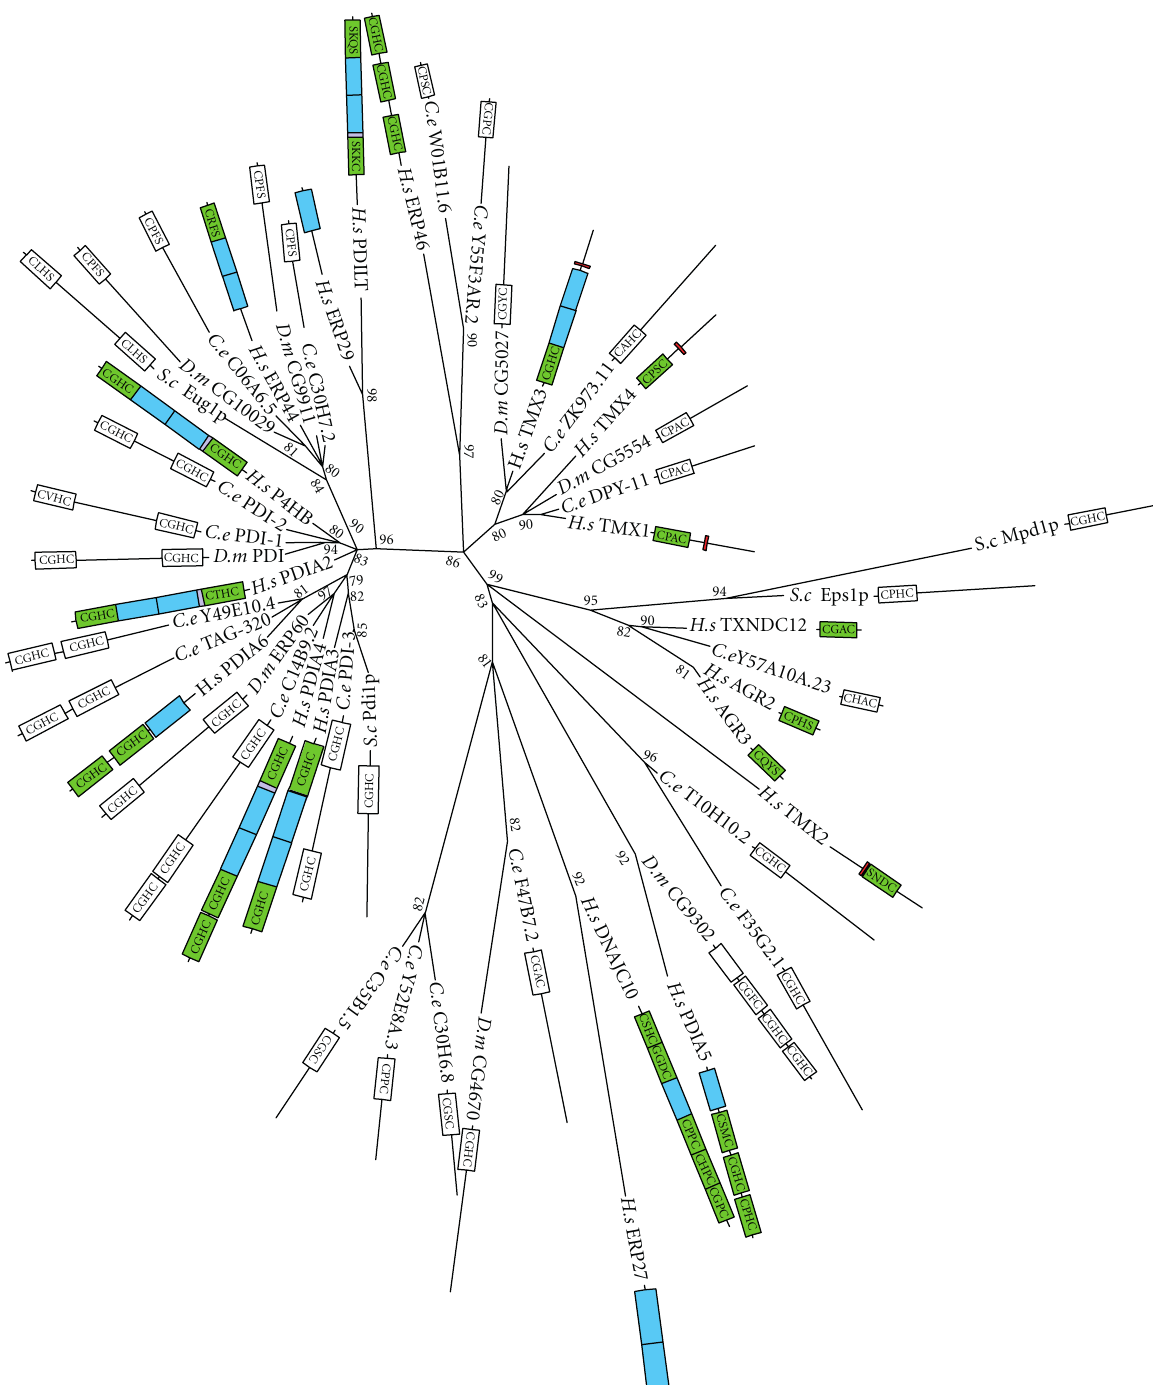
Figure 8: Maximum likelihood majority-rule bootstrap consensus tree of protein disulfide isomerase (PDI) proteins. Green boxes are likely TRX-like fold in human PDI; blue are likely noncatalytic thirodoxin domains (according to Hatahet and Ruddock [62]). White boxes show CxxC catalytic motifs, in C. elegans and D. melanogaster . Although domain structure cannot be inferred from sequence alone, it is likely that proteins that share similar sequences, catalytic motifs, and length also share a similar domain structure and in some cases are likely orthologous. See Figure 5 for details of how the sequences were identified and processed as well as how the phylogenetic analysis was carried